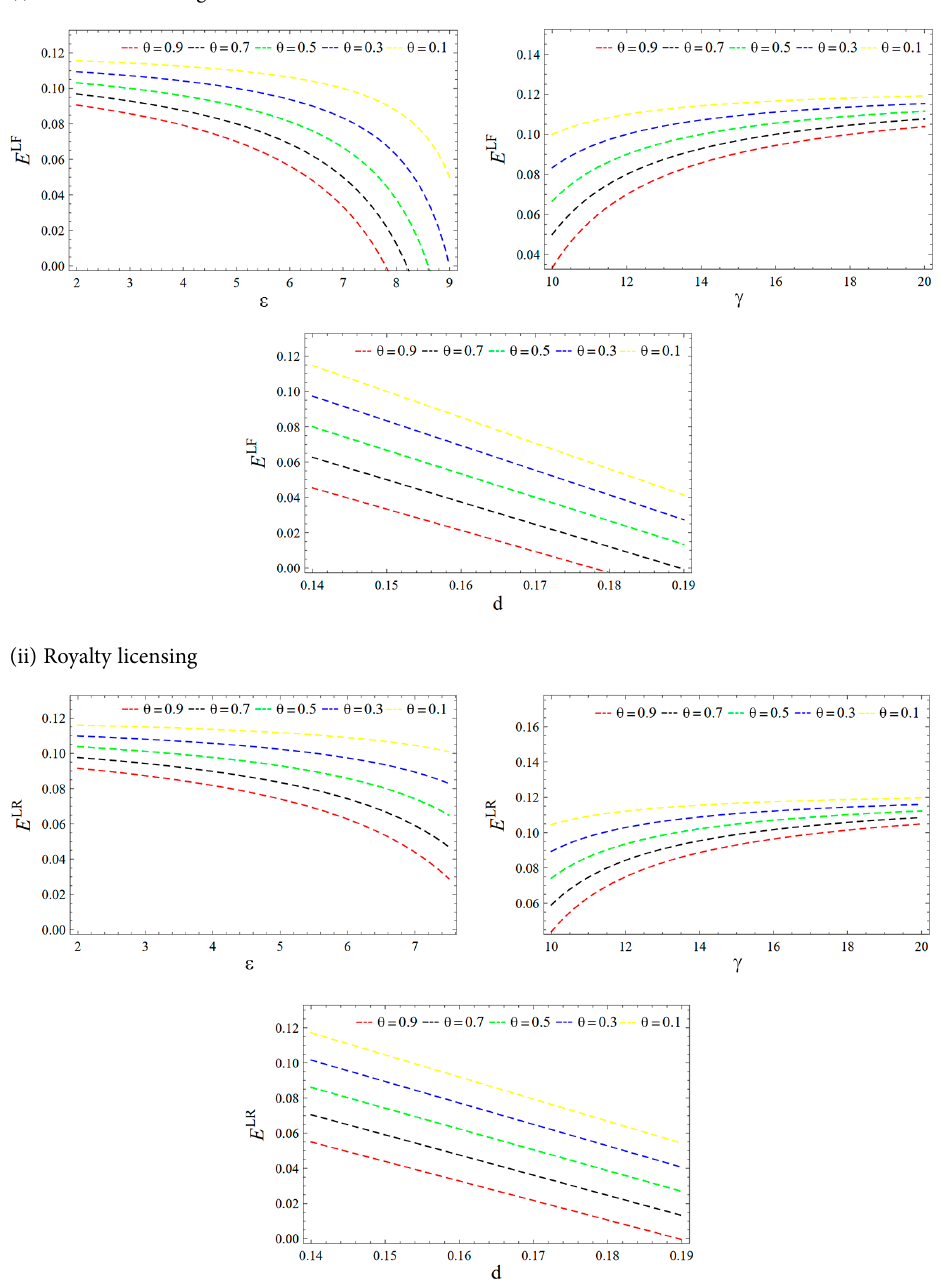
Figure 3. Analytical sensitivity on E LR ( F ) with different